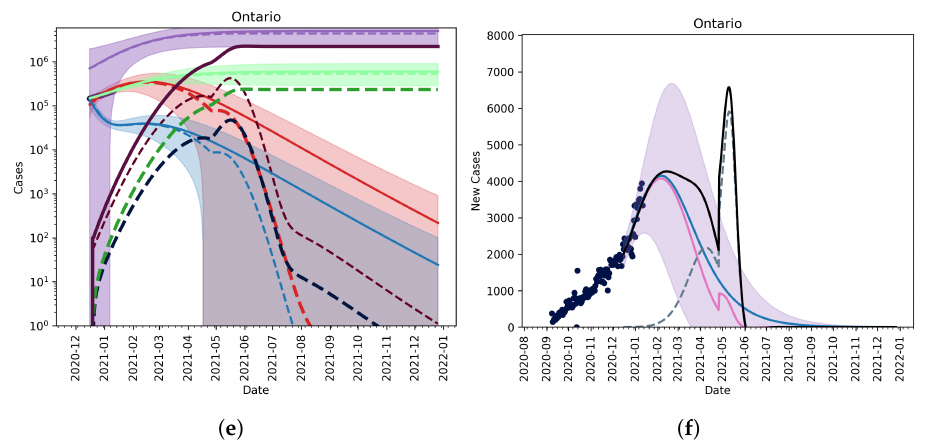
Figure 3. Model fit given vaccination and relaxation. ( Top row , ( a , b )) vaccination without relaxation, ( middle row , ( c , d )) vaccination with slow relaxation, and ( bottom row , ( e , f )) vaccination with fast relaxation. Vaccination assumes that 10% of the population is vaccinated by 31 March 2021 and that 75% of the population is inoculated by the end of 2021. Relaxation allows for rules and behaviours to change in a way that allows for more contact between individuals. We assume that behaviours will eventually lead to pre-February 2020 contact rates between individuals. (Left column) The active and cumulative cases are shown given the model with (dashed lines) and without (solid lines) the mutant strain (dashed lines). Active mild and severe wildtype infected cases are shown in red and blue. Active and severe mutant infected populations are shown in dark red and dark blue. The cumulative known and total cases of the wildtype and mutant strains are shown in light and dark green, and light and dark purple, respectively. (Right column) The new reported cases per day given the model with (wildtype—solid pink line, mutant—dashed blue line, and total—solid black line) and without (wildtype—solid blue line) the mutant. Ontario reported case data, from September 2020 to January 2021, are also shown (dots).